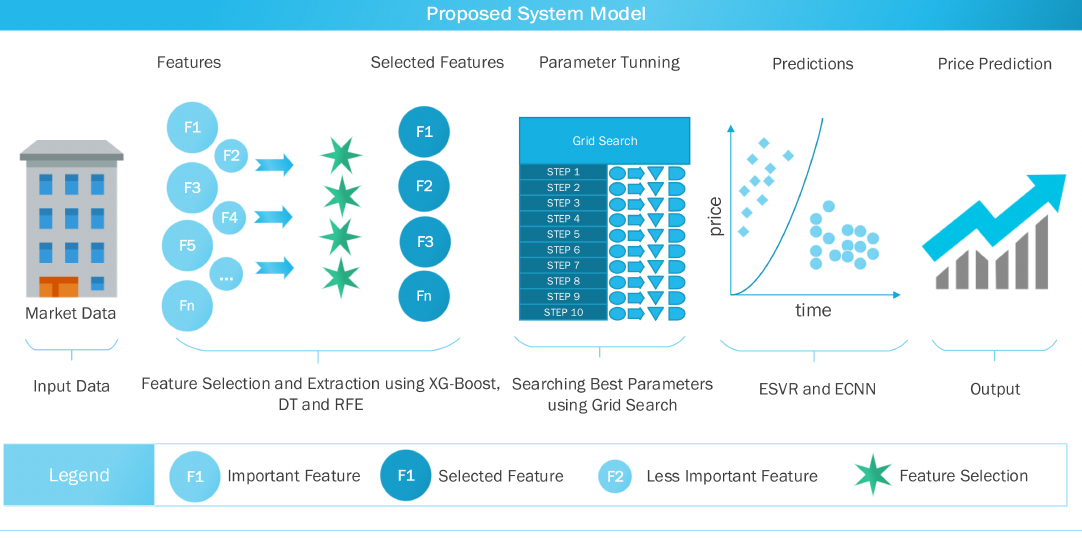
Figure 2. Proposed Model for Price